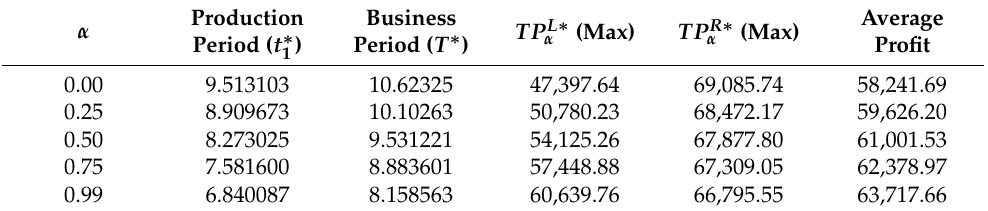
Table 7. Optimum results of Example 2 for maximizing both TP L α and TP R α .